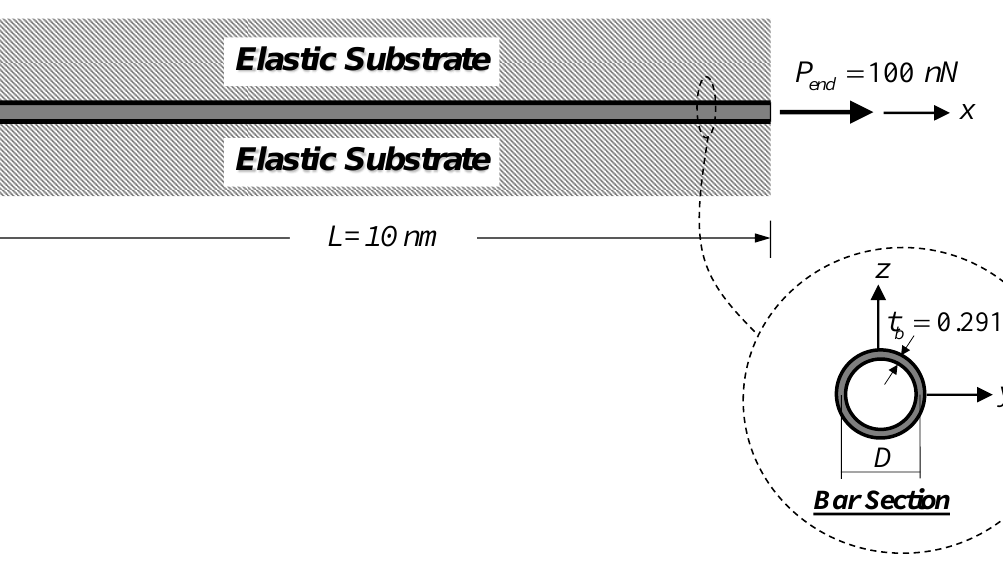
where K s represents a stiffness coefficient of the substrate medium and is defined as K s = k s / D . This range of the dimensionless substrate-stiffness parameter, K s , follows that employed by Demir et al. [67].